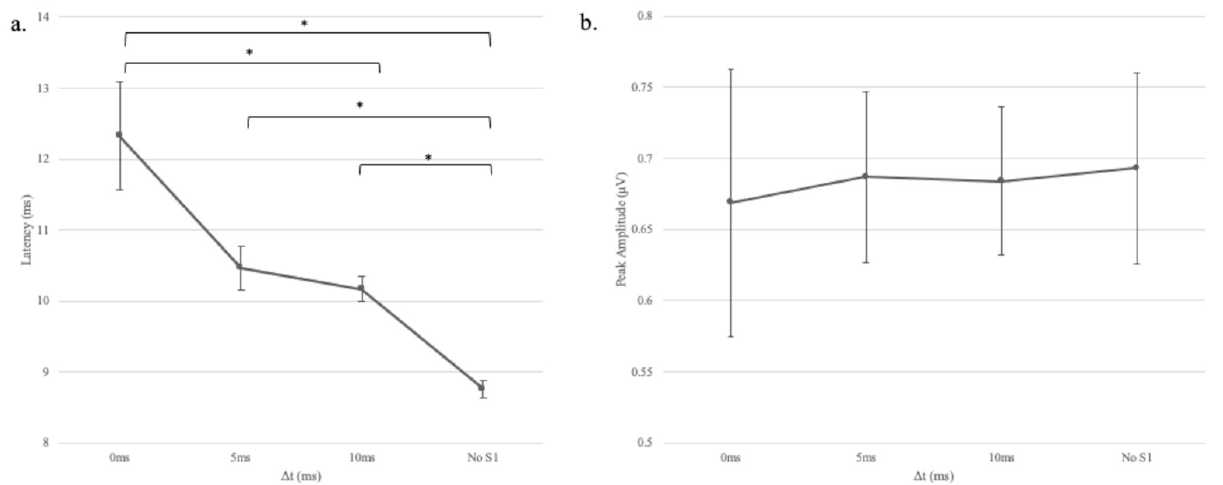
Figure 5. Mean response latencies (panel a ) and amplitudes (panel b ) for different gap durations ( ∆ t). Error bars indicate +/– one standard deviation from the mean. One asterisk represents p < 0.05.